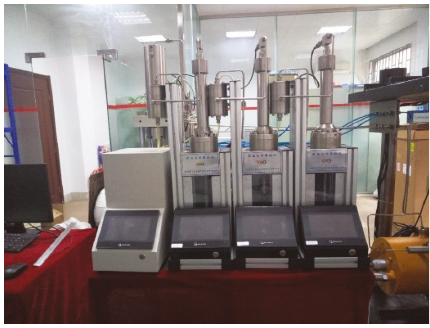
Figure 6: Metering pump for constant speed and constant